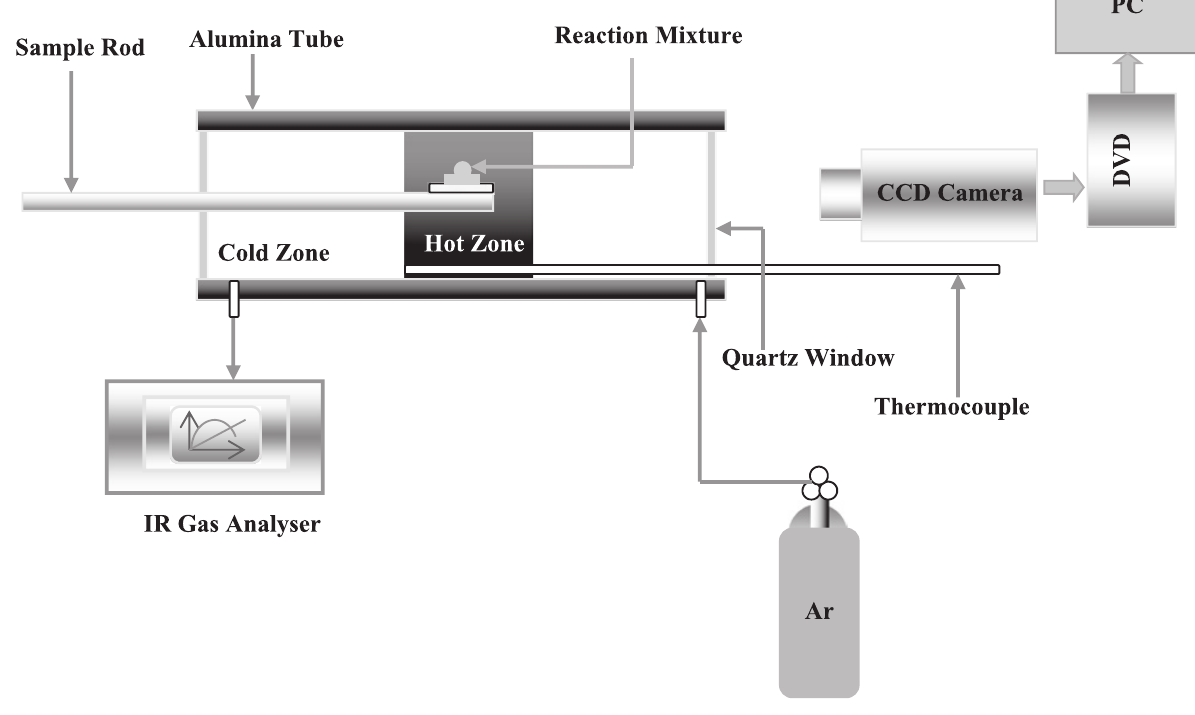
Fig. 4: Schematic of the horizontal tube furnace and IR gas analyser system